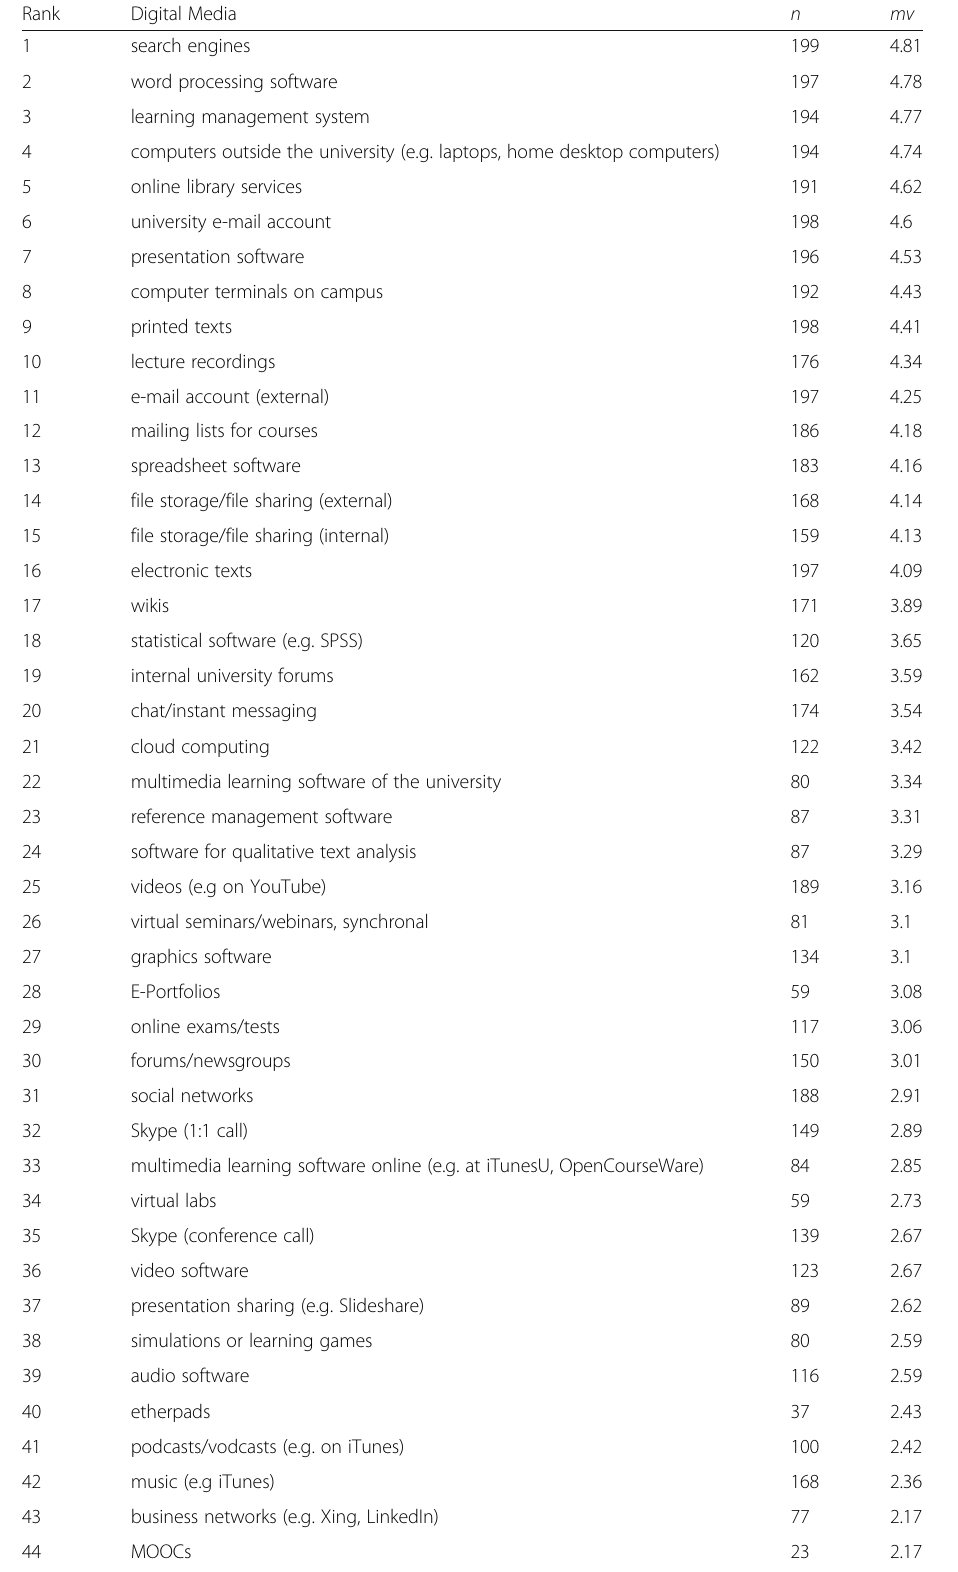
Table 4 Ranking by mean - ‘ How useful do you find these digital media tools for your studies?